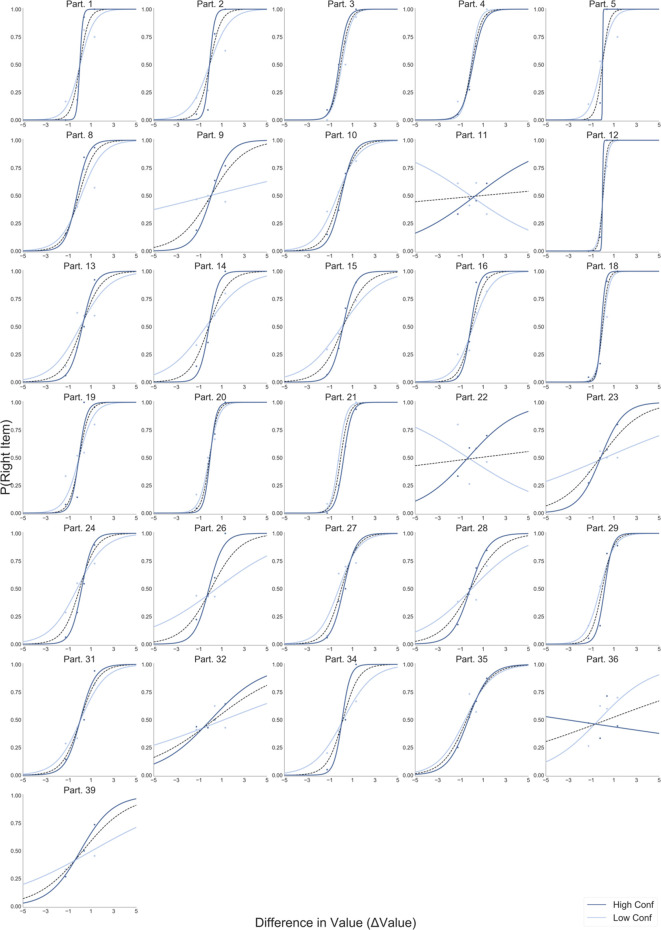
Logistic regression predicting choice from the difference in value between the two items (∆Value).All participants in the Value Experiment, like frame, are presented. Light blue lines depict the logistic fit calculated using only low confidence trials. Dark blue lines show the logistic fit only for high confidence trials. Segmented black line considers the logistic regression calculated using all the trials.